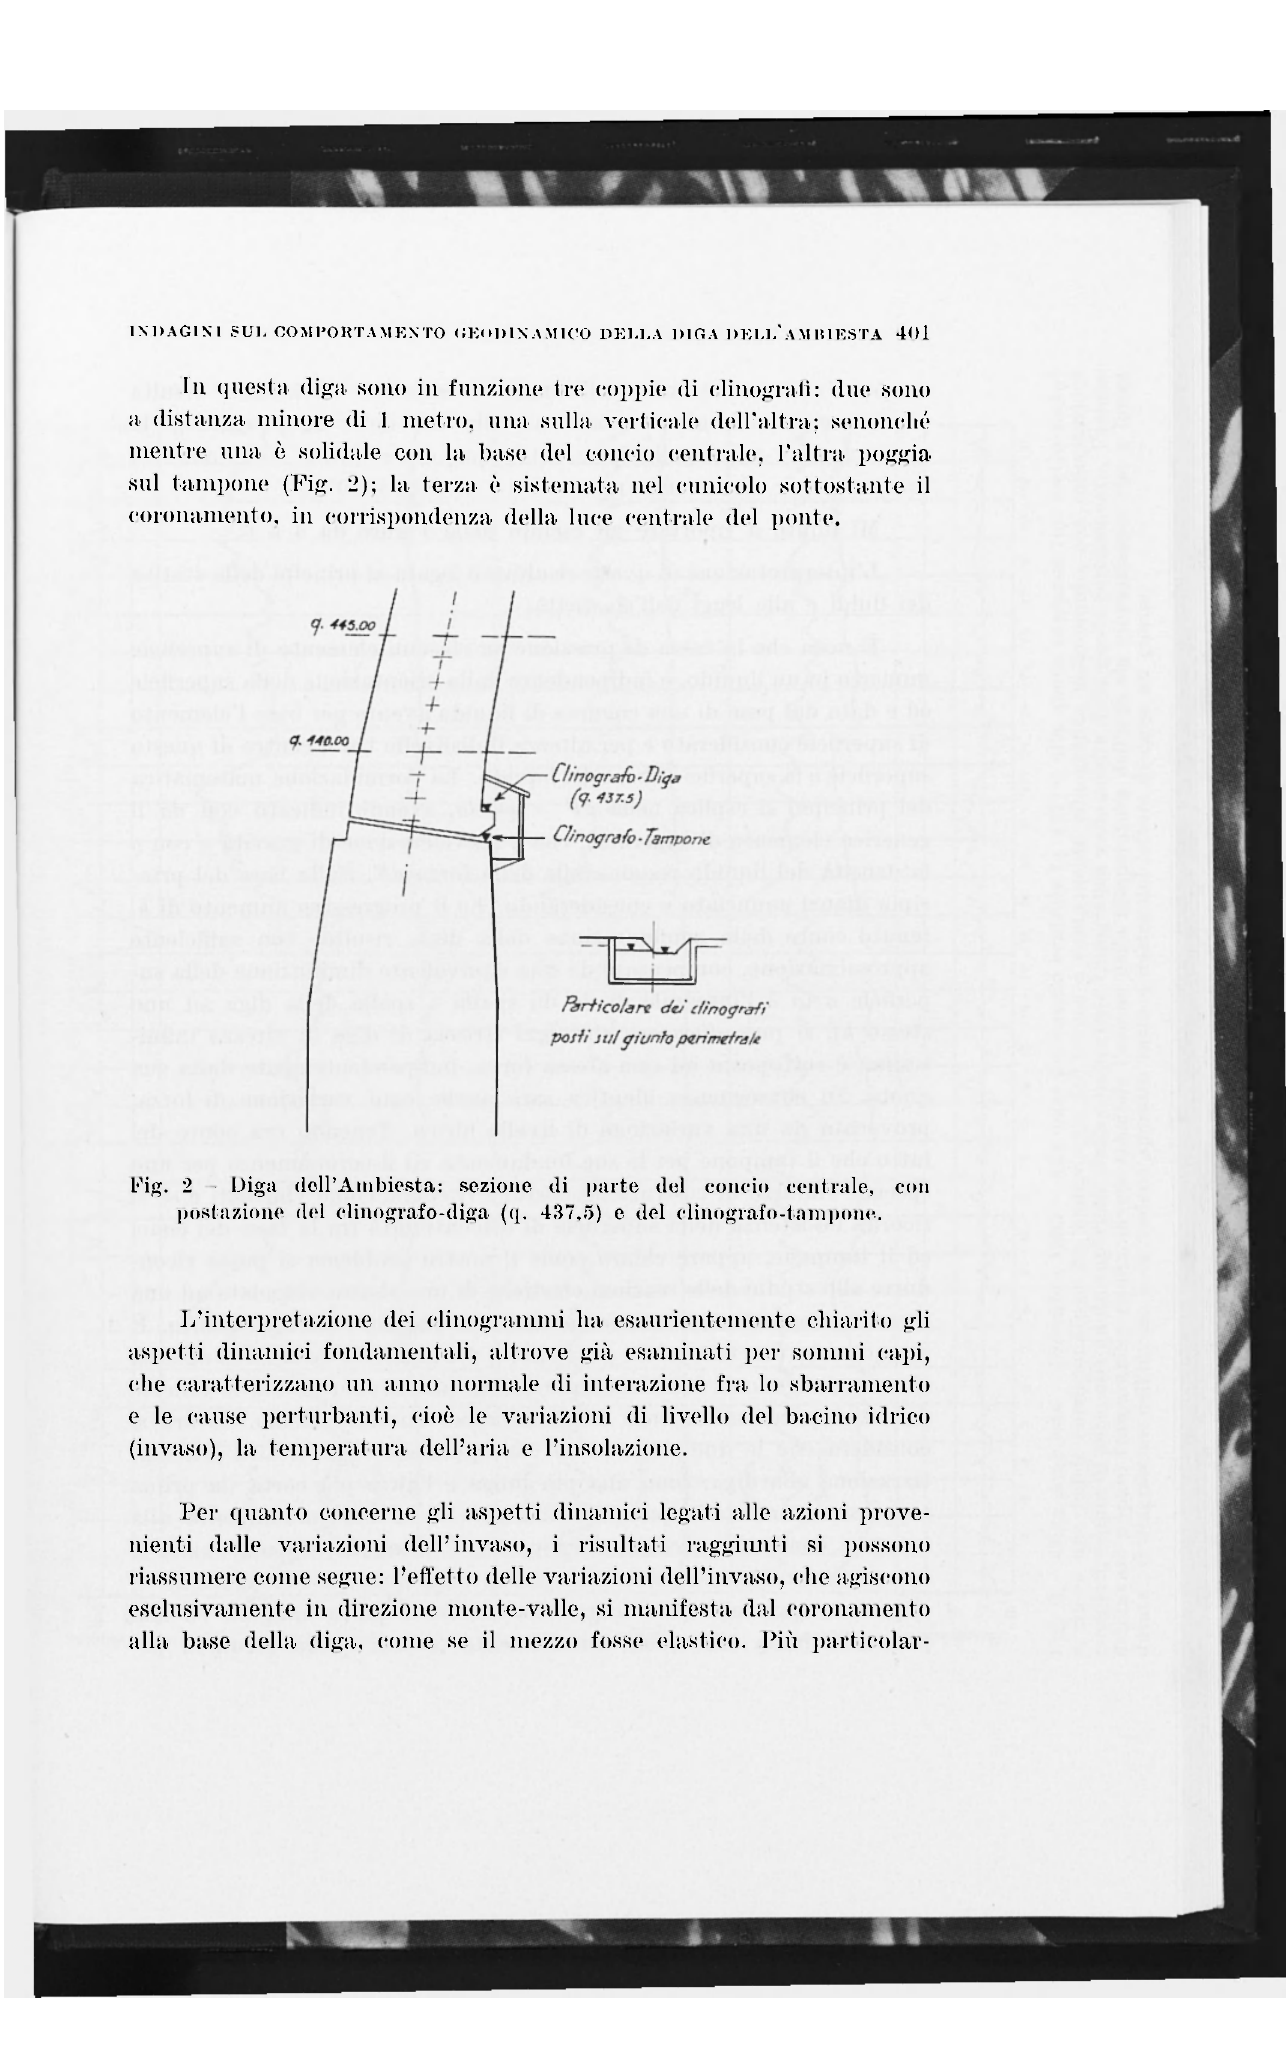
L'interpretazione dei clinogrammi ha esaurientemente chiarito